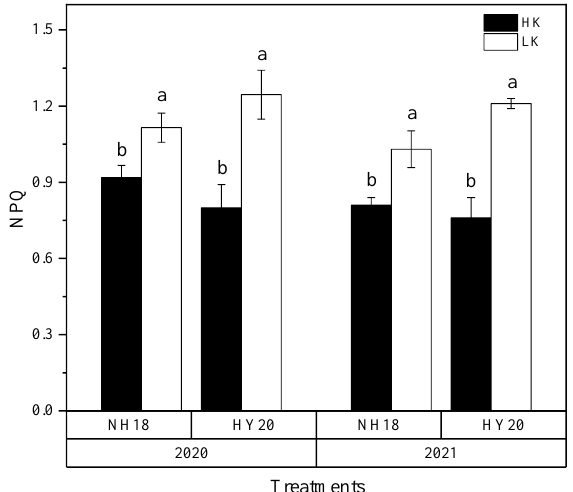
Figure 10. Effect of low K stress on non-photochemical quenching coefficient. HK: high K treatment; LK: low K treatment. For the bar chart, a,b indicates a significant difference between different treatments for the same variety ( p <